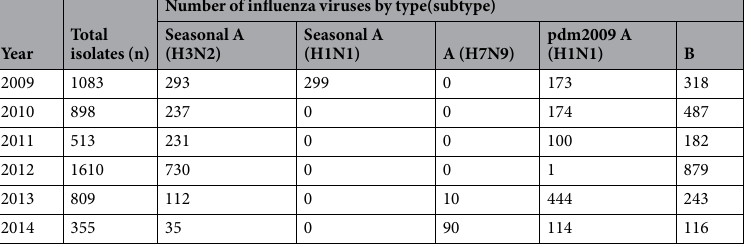
Table 1. Number of influenza viruses isolated in Guangdong, China from 2009 to 2014.